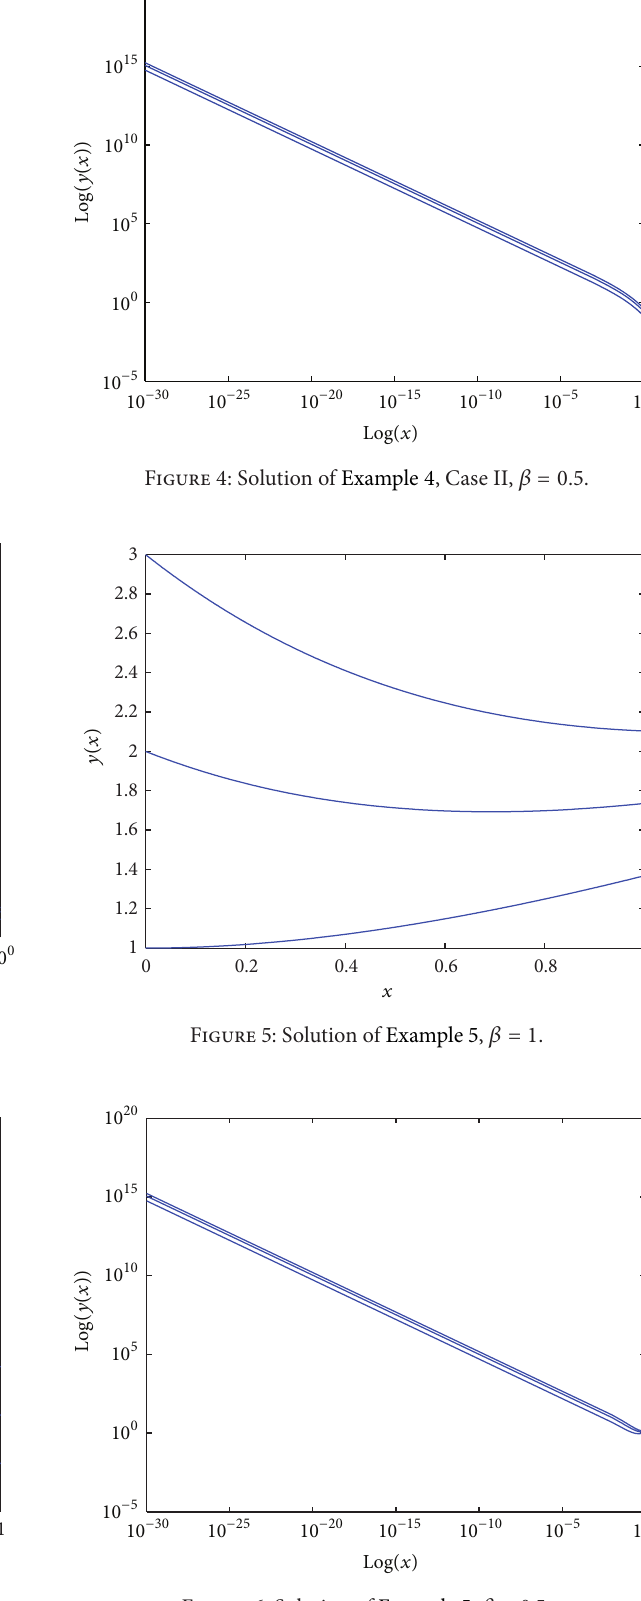
Figure 6: Solution of Example 5, 𝛽 = 0.5